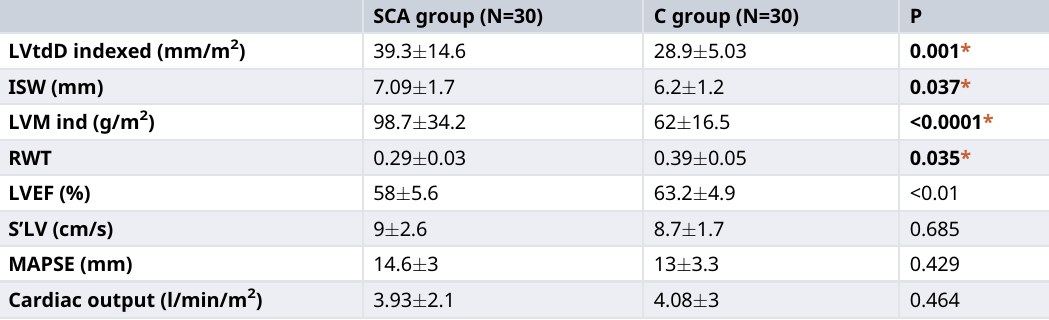
Table 3. Comparison of LV morphological parameters and LV systolic function in the two groups.